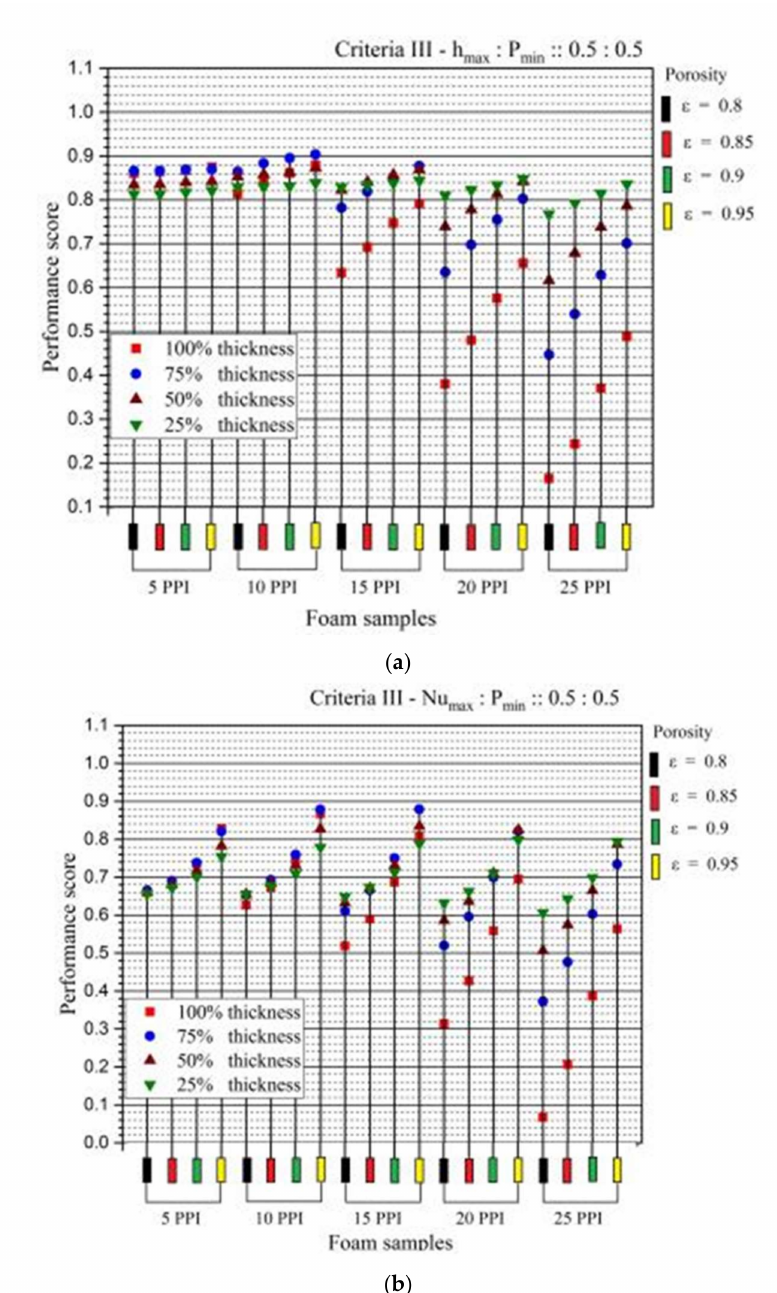
Figure 12. ( a ) Criteria III (h max :P min ). ( b ) Criteria III (Nu max :P min